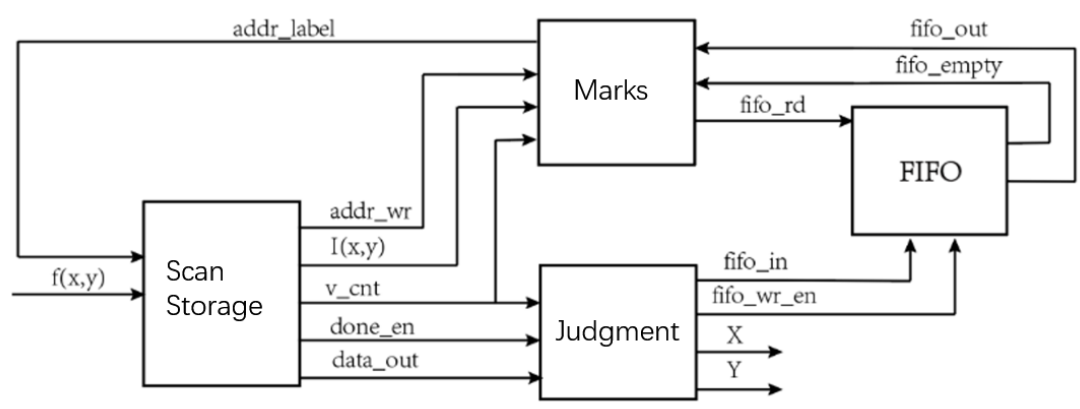
Figure 10. FPGA hardware implementation.